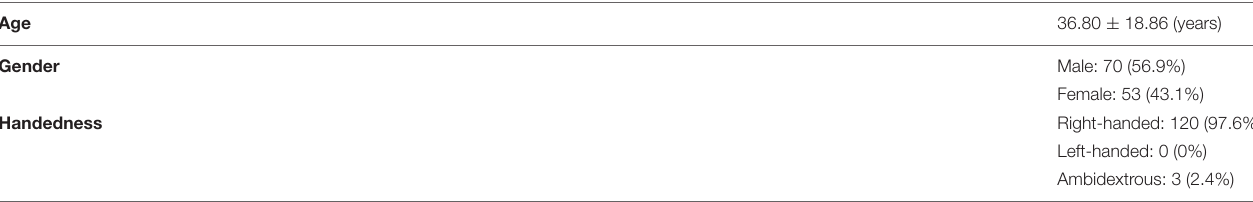
TABLE 1 | Demographic characteristics of study participants ( n = 123).